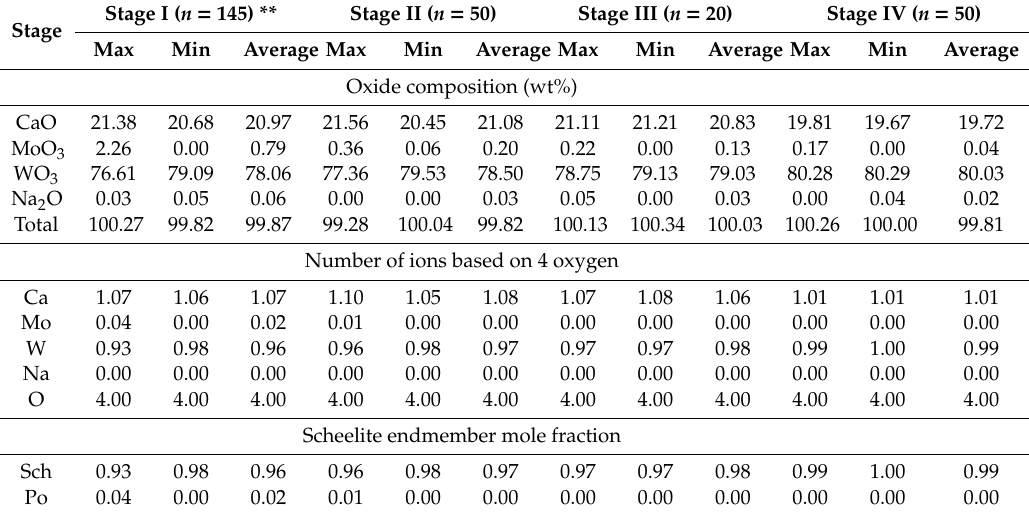
Table 1. Major element analysis data of Sangdong scheelites (in brief)